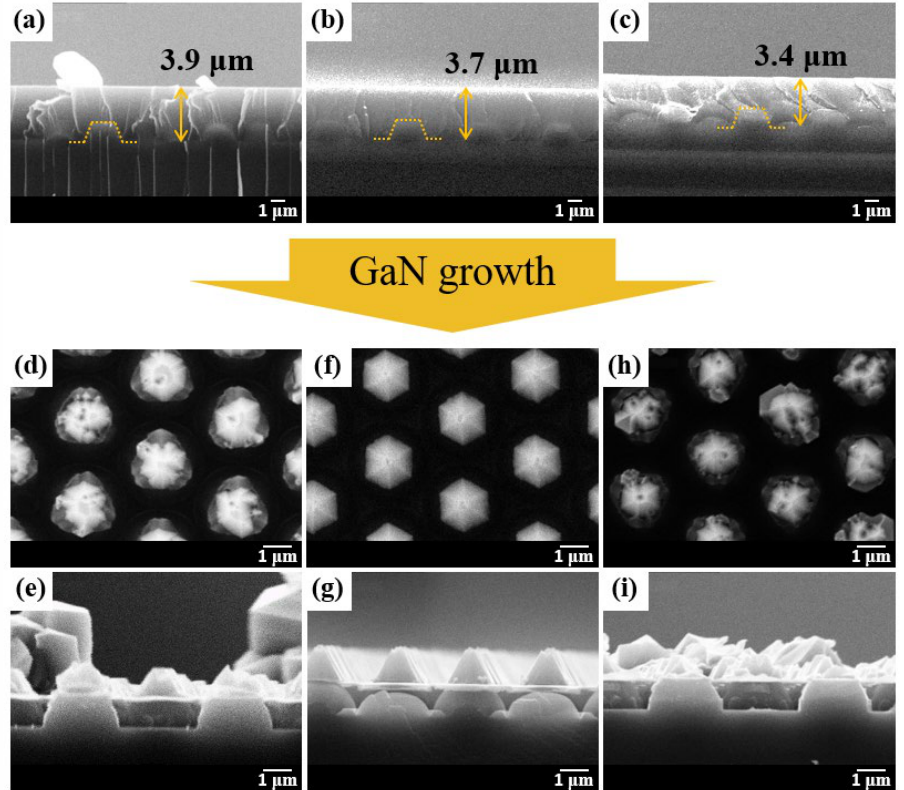
Figure 2. Cross - sectional SEM images of photoresist layers spin - coated at speeds of ( a ) 3200 rpm, ( b ) 3700 rpm, and ( c ) 4200 rpm. The dashed lines and arrows represent the TPSS lens and the thickness of photoresist layer, respectively. Top and cross - sectional SEM images of GaN grown on sample spin - coated at ( d , e ) 3200 rpm, ( f , g ) 3700 rpm, and ( h , i ) 4200 rp m.